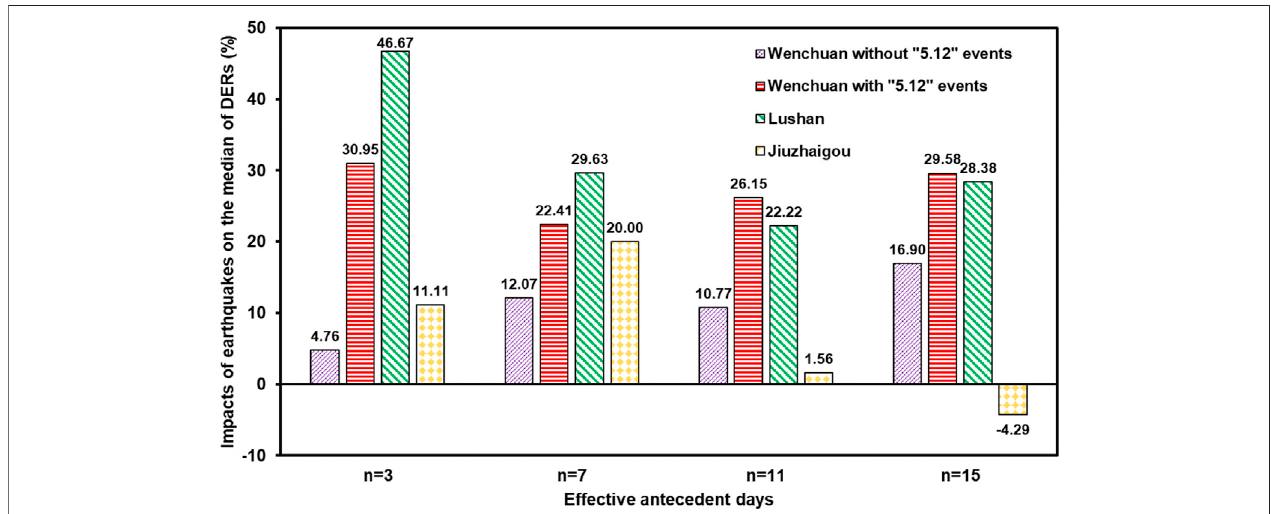
FIGURE3| Impactsofeachearthquakeonrainfallthresholdswithdifferentnsettings.niseffectiveantecedentrainydays.Thepositivevalueindicatesthedecrease of the regional rainfall threshold.